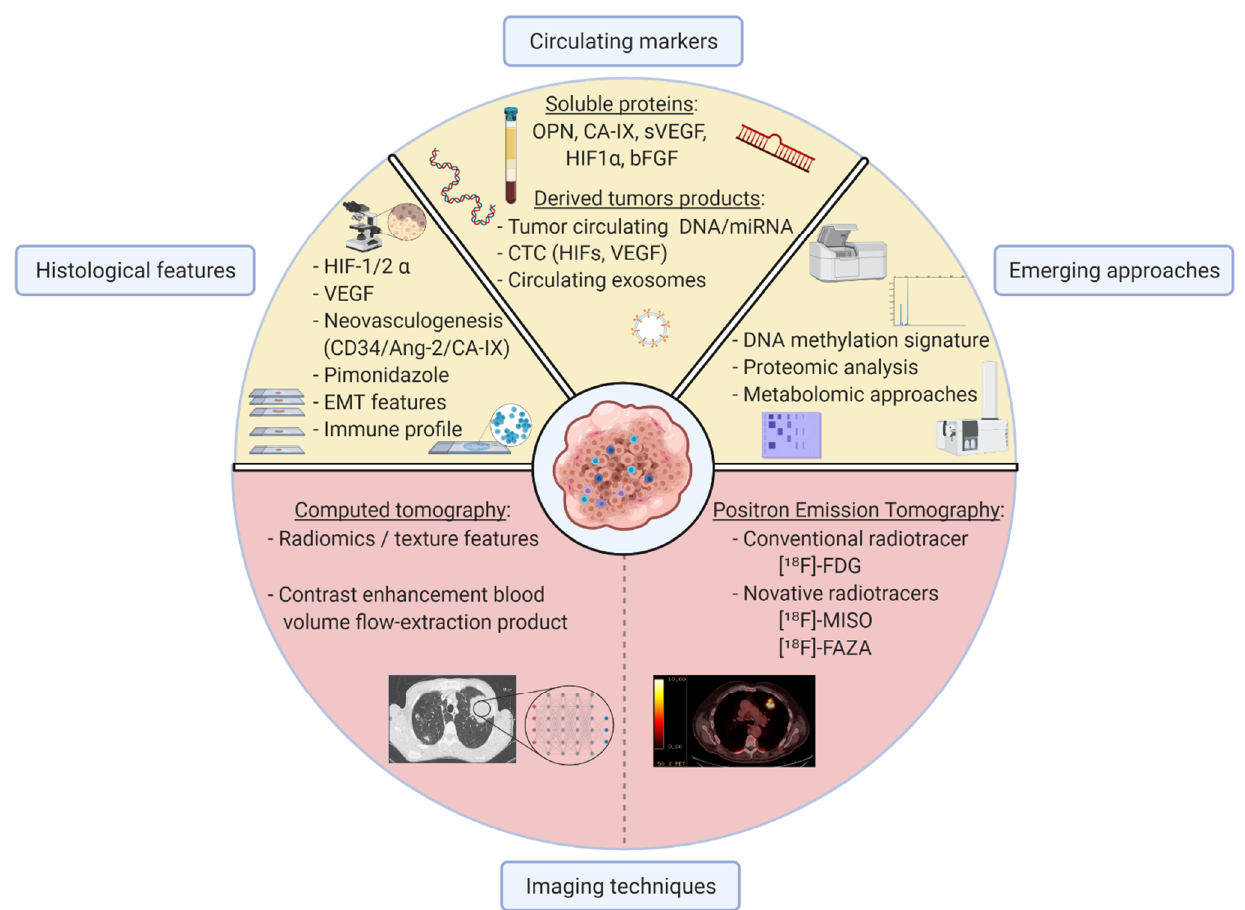
Figure 2. Molecular, cellular, and whole-organism techniques to assess hypoxic status in lung cancer. Various methods to define hypoxic features are currently available or in development to meet clinician’s expectation. Table 1. Hypoxia-related markers with a clinical interest in non-small cell lung cancer. HIF-1 α: hypoxia-inducible. Figure